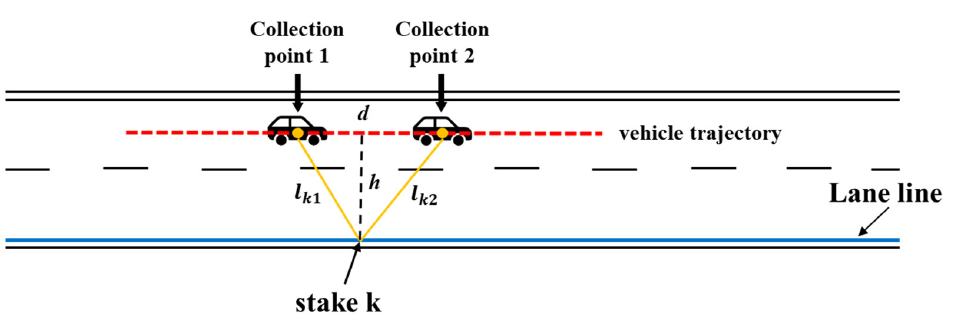
Figure 13. Schematic diagram of lateral distance extraction.